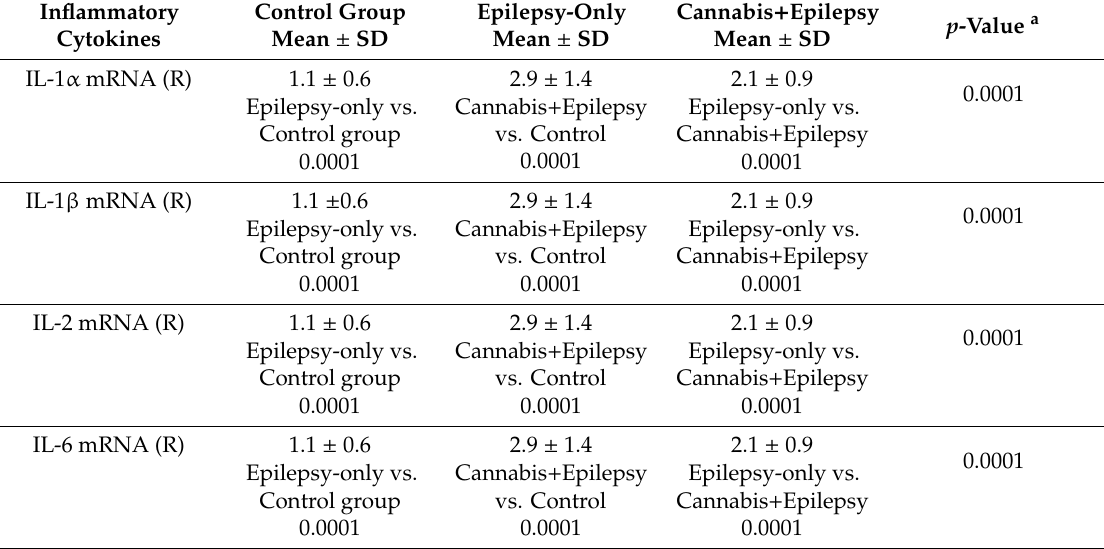
Table 4. Comparisons of the cytokine gene expression among the Control group, the Epilepsy-only group and the Epilepsy + Cannabis